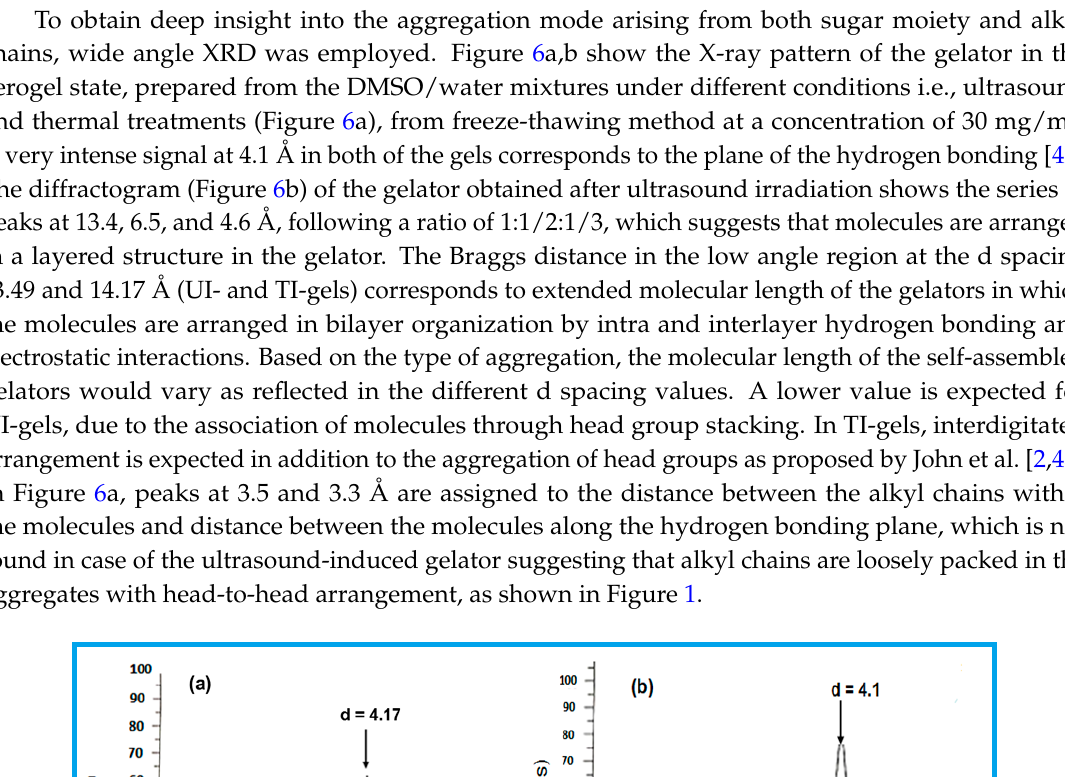
Figure 5. Storage modulus G ′ and loss modulus G ″ as a function of ( a ) angular frequency; ( b ) shear stress for gels at a concentration of 30 mg/mL.